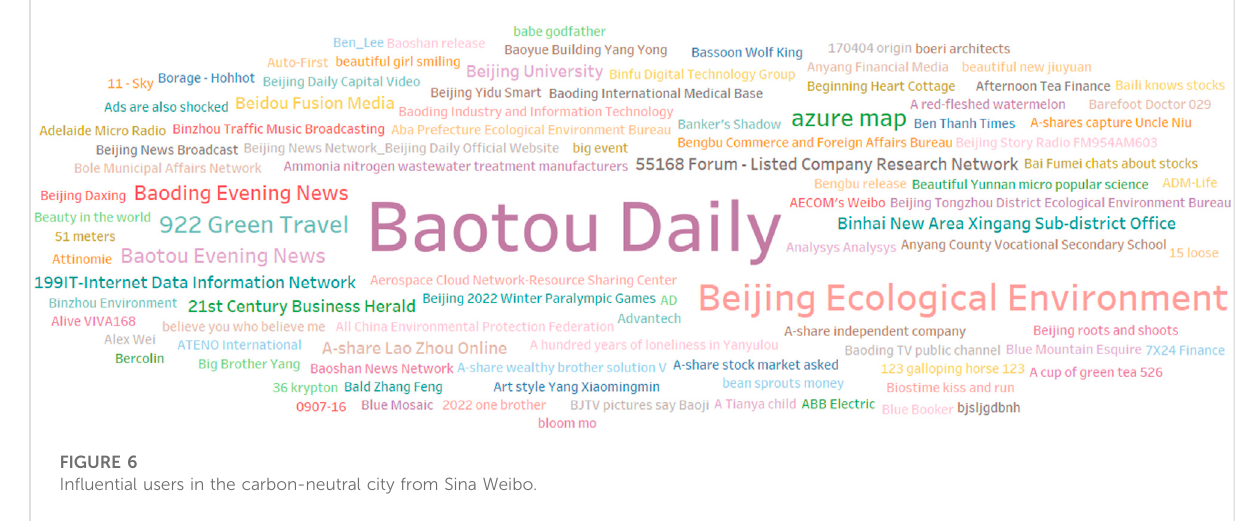
In fl uential users in the carbon-neutral city from Sina